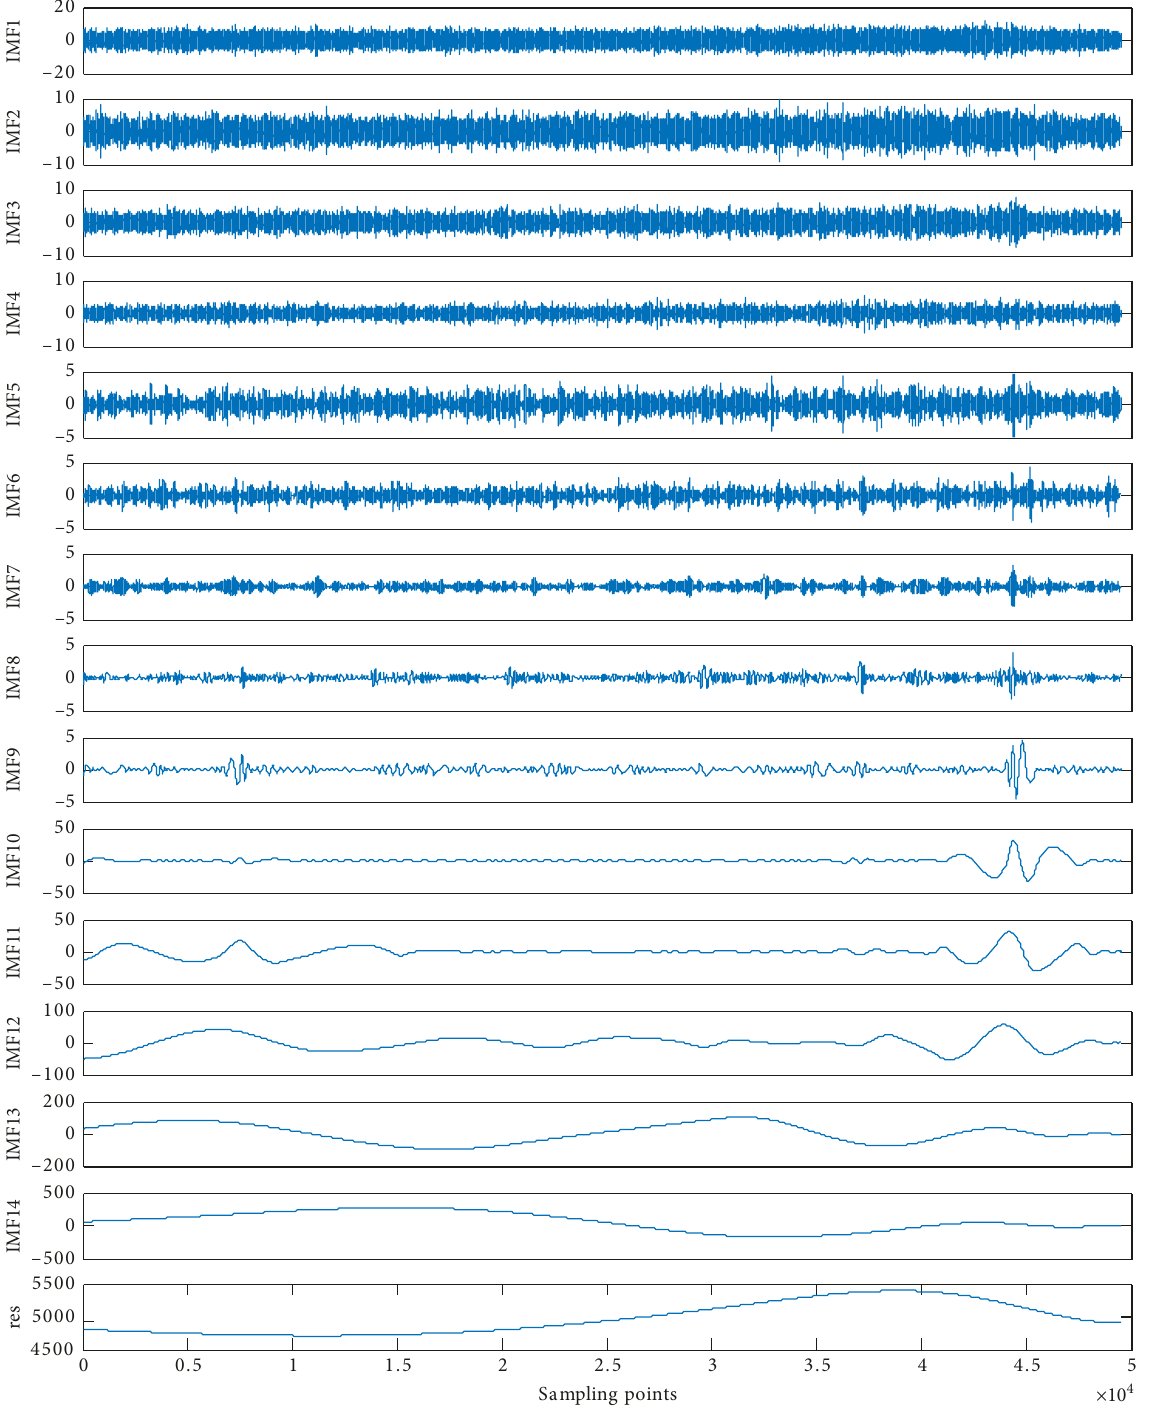
Figure 10: EMD decomposition